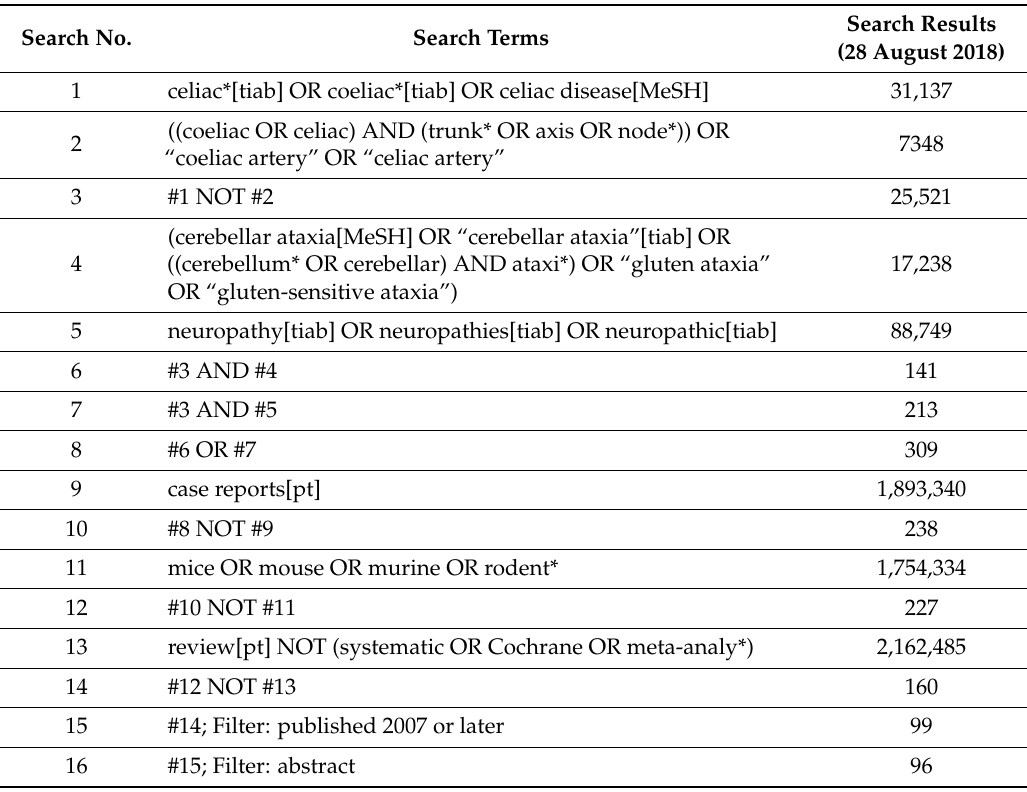
Table 1. MEDLINE (via PubMed.com) Search